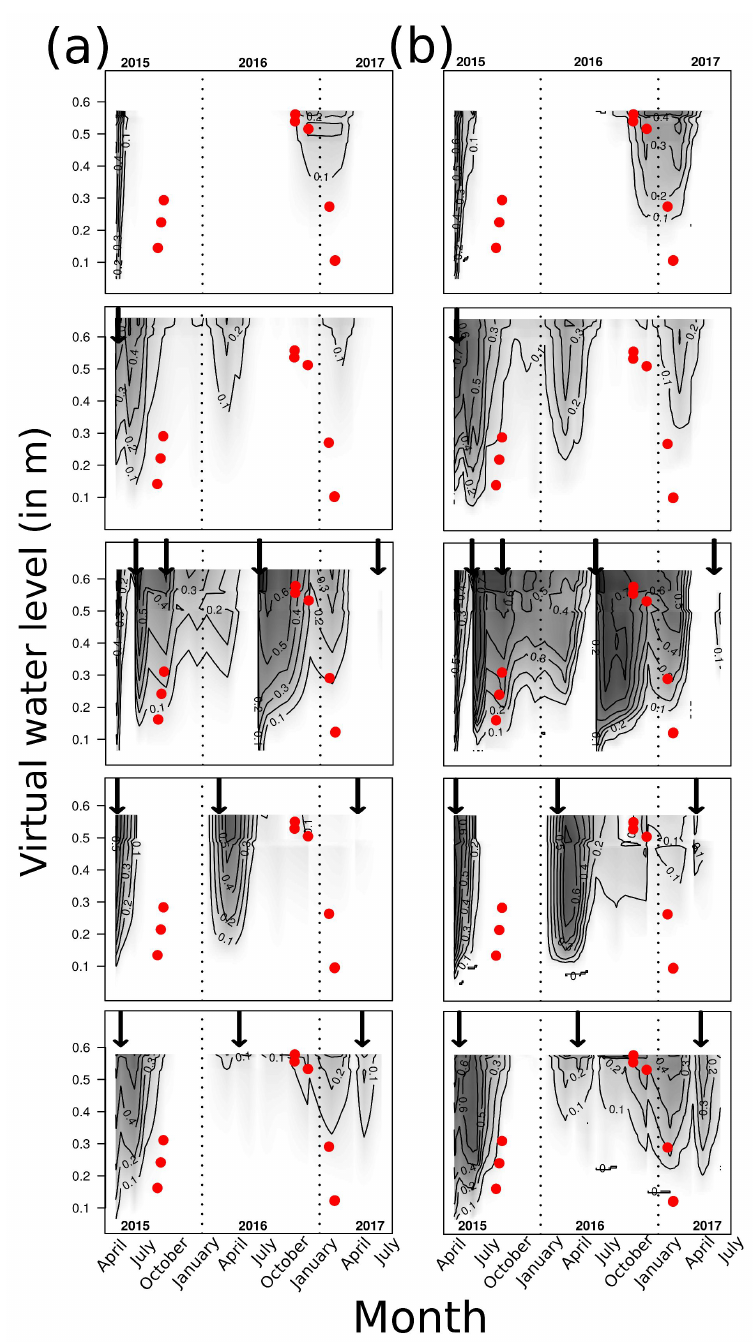
Figure 7. Dynamics of the vegetation indicators across different treatments presented in columns from left to right: control, dredged, mowed, burned, and chemically weeded. ( a , b ) from top to bottom, contour plots of the porosity indicators PORO section and PORO surface against virtual water level on the ordinate and time on the abscissa. Values of porosities are between 0 (non-porous) and 1 (totally porous). Contour lines are drawn on the plots to better represent the variation in the indicators. The red dots represent the peaks of water levels for the main flow events during the study period. Vertical dashed lines delimit years. Black arrows indicate the timing of the practice.